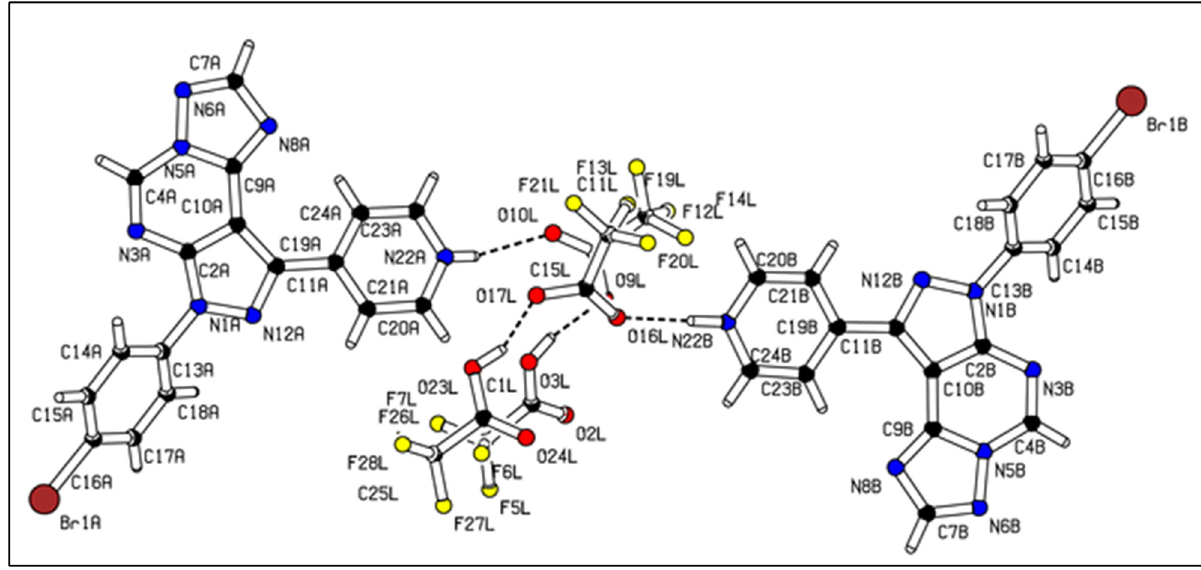
Figure 6. X-ray molecular structure of compound 3 .